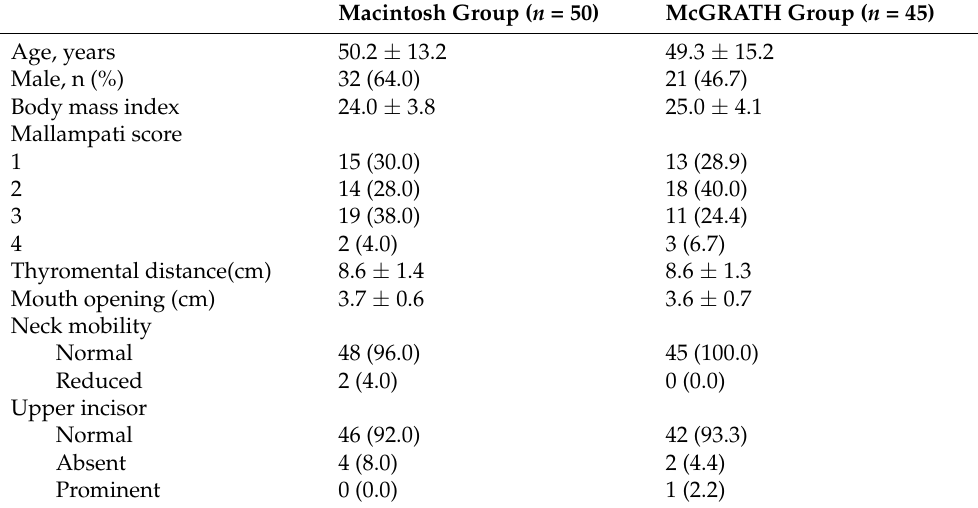
Table 1. Patient characteristics.